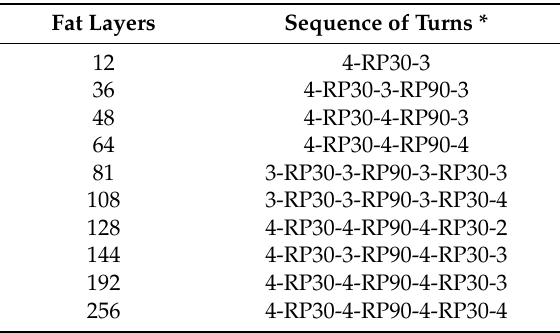
Table 2. Theoretical number of fat layers and sequence of